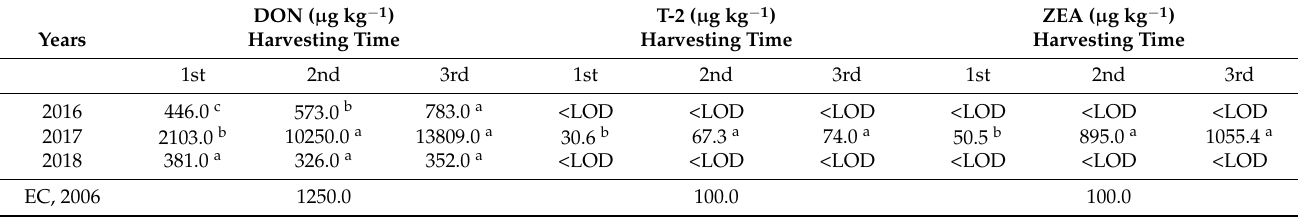
Note. Values followed by the same letter in a row are not significantly different (Duncan’s multiple-range test, p < 0.05). 1st—harvesting time when wheat reached full maturity (BBCH 89), 2nd—full maturity + 10 ± 2 days, 3rd—full maturity + 17 ± 3 days. LOD—limit of